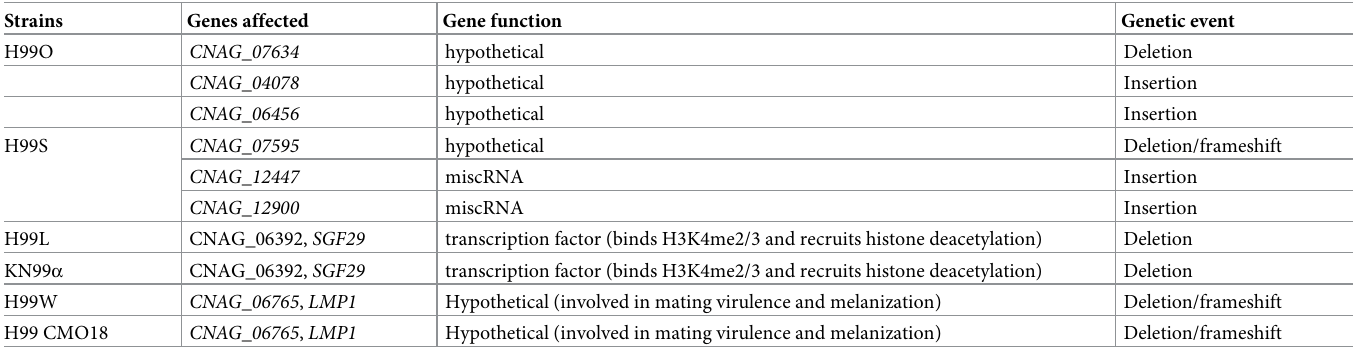
Table 1. Genes affected by SNPs or Indels in the different H99 strains. Strains Genes affected Gene function Genetic